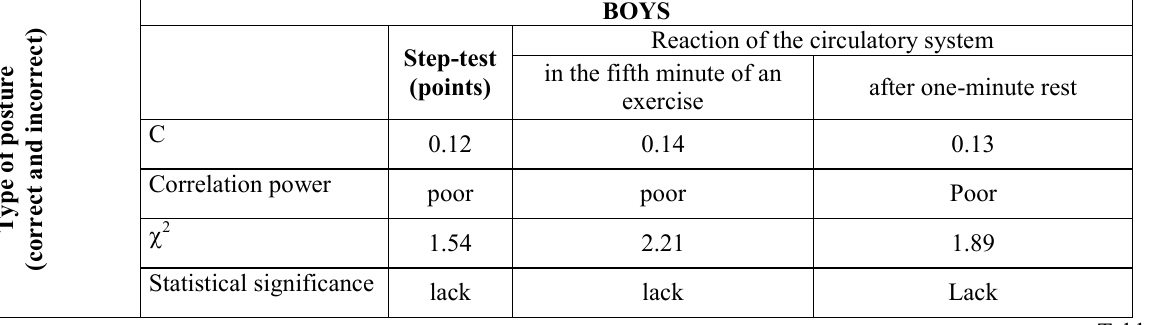
Correlations occurring between the posture (correct and incorrect) and the number of points scored in the step-test and the reaction of the circulatory system in the fifth minute of an exercise and after one-minute rest in the boys involved in